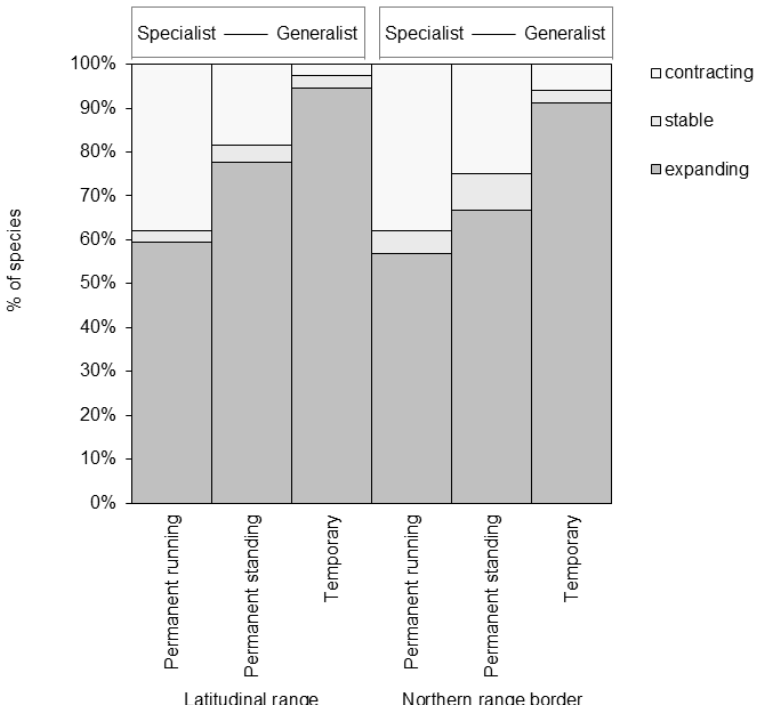
Figure 5. Percentage of European dragonfly (Odonata) species in three ecological habitat categories— permanent running (perennial lotic) water, permanent standing (perennial lentic) water, and temporary (running and standing) water habitats—that have experienced expanding, stable, or contracting latitudinal range or northern range border between 1988 and 2010. Top scale represents a gradient going from habitat specialist with a narrow niche breadth to habitat generalist with a broad niche breadth.